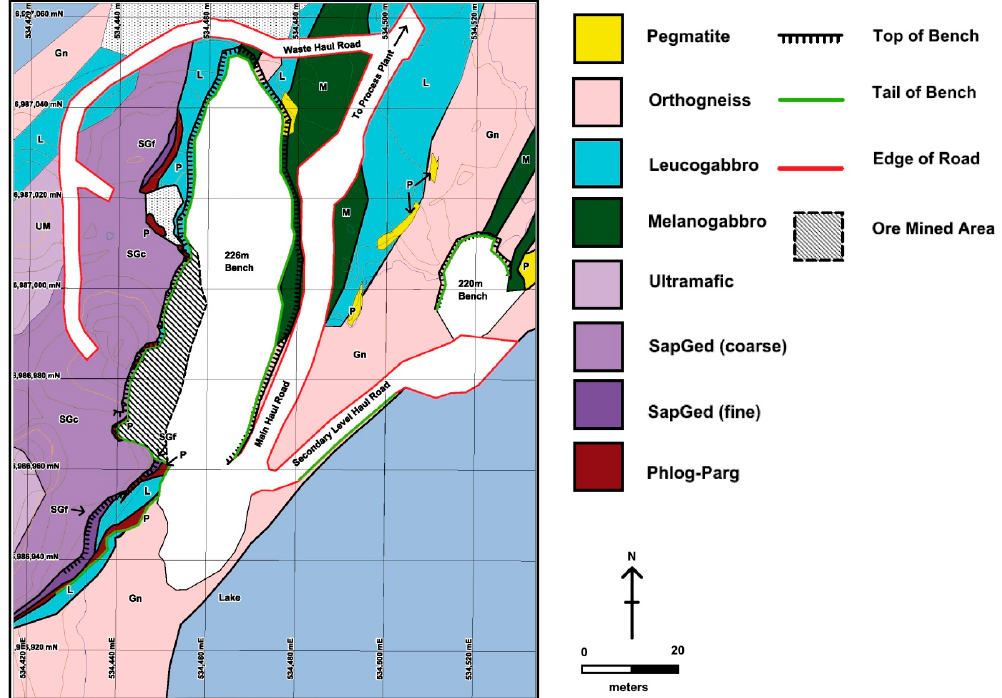
Figure 44. Geological map of the Aappaluttoq ruby mine [34]. SapGed: sapphirine-gedrite; Phlog-Parg: phlogopite-pargasite; Gn: orthogneiss; SGc and SGf: coarse (c) and fine (f) sapphirine-gedrite; L: leucogabbro; M: melanogabbro; UM: ultramafic rock; and P: pegmatite (yellow) or phlogopitite